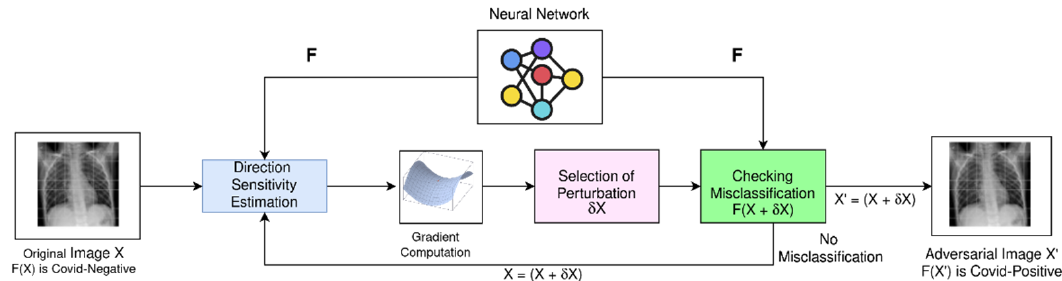
Figure 3. Adversarial image generation approach using FGSM attack.